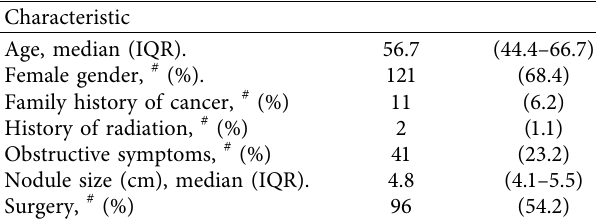
Table 1: Characteristics of patients who had a thyroid nodule ≥ 4.0cm ( n �